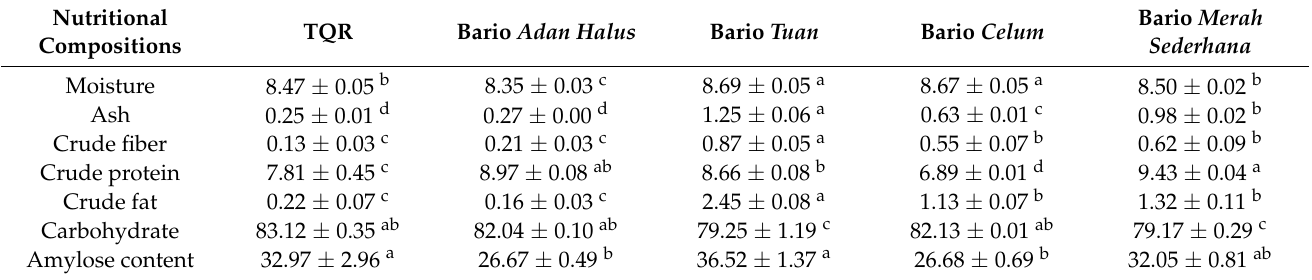
Table 1. Nutritional compositions of Bario rice flour varieties and TQR rice flour as a reference